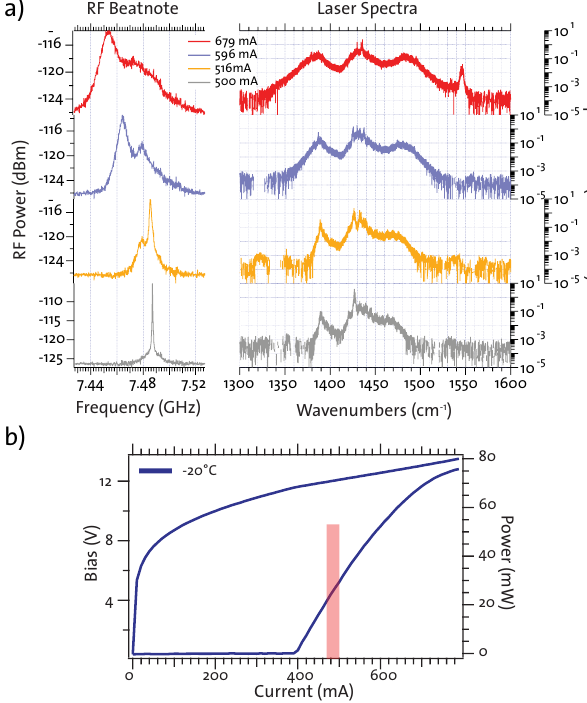
Figure 11: QCL comb operation regimes. a Left side: RF beatnote spectra measured using a fast quantum well photoconductor, to- gether with its respective optical spectra (right graphs) of a QCL de- signed for comb operation. Above a certain value of current (510mA in this example), the RF beatnote splits into two distinctive beats. b Corresponding light intensity–current–voltage characteristics of the device. The shaded area corresponds to the region where the narrow beatnote is observed. Results published in